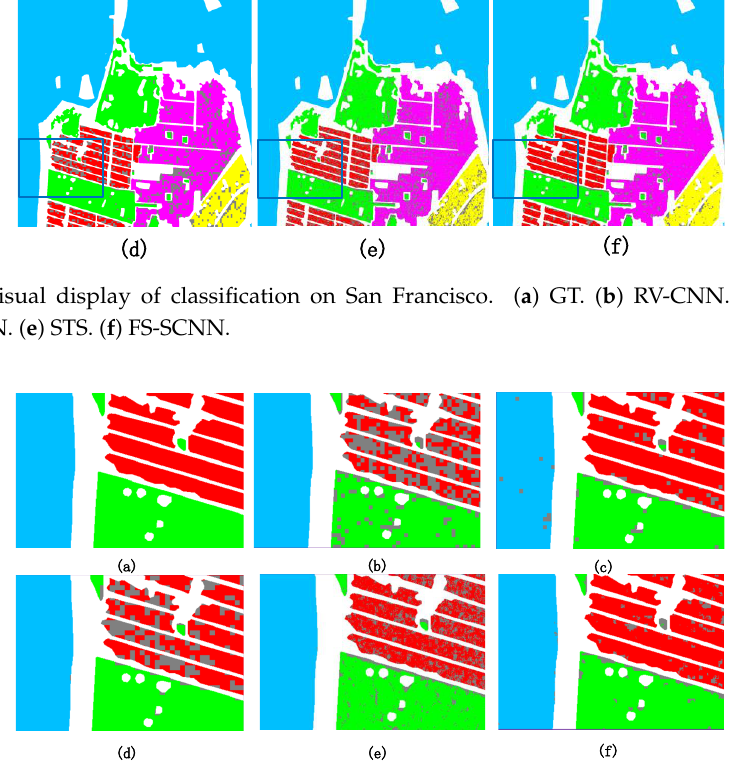
Figure 9. The enlarged images of the selected region in Figure 8. ( a ) GT. ( b ) RV-CNN. ( c ) CV-CNN. ( d ) LS-QCNN. ( e ) STS. ( f )